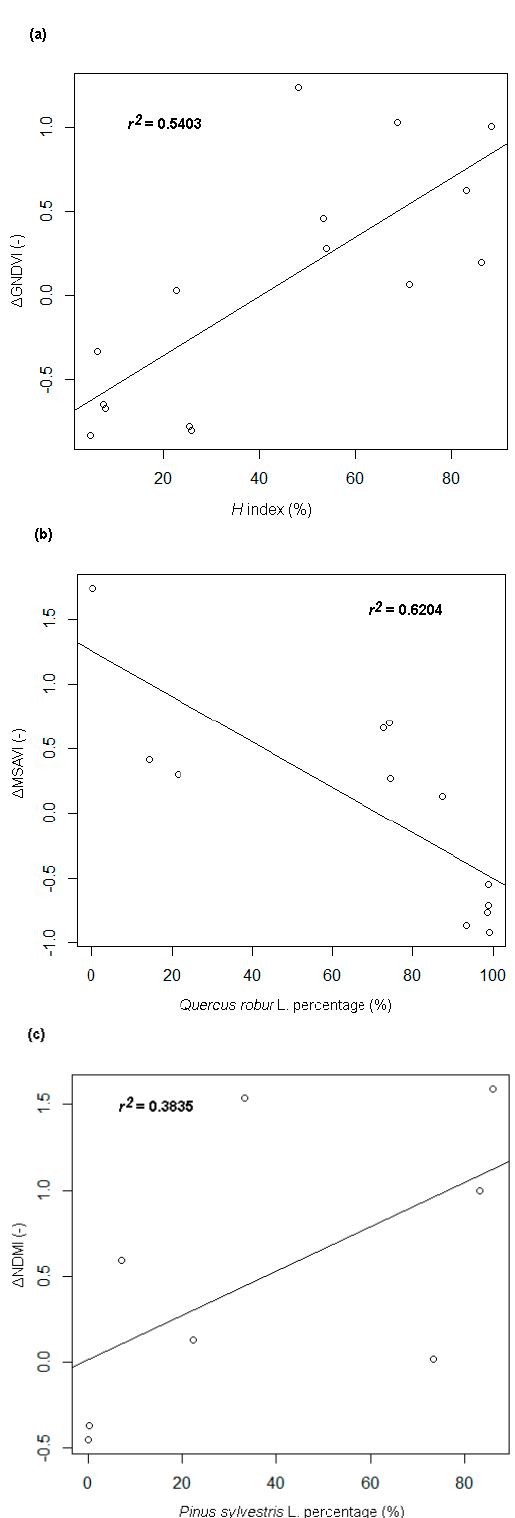
Figure 4. ( a ): Diversity index H in relation to the value of the Δ GNDVI index; ( b ): percentage share of the Q. robur species in relation to the value of the Δ MSAVI index; ( c ): percentage share of the P. sylvestris species in relation to the value of the Δ NDMI index. Coefficients of determination ( r 2 ) indicate that Δ GNDVI index was predictable from H index (positive correlation), Δ MSAVI index was predictable from the percentage share of the Q. robur species (negative correlation), and Δ NDMI index was predictable from the percentage share of the P. sylvestris species (positive correlation).